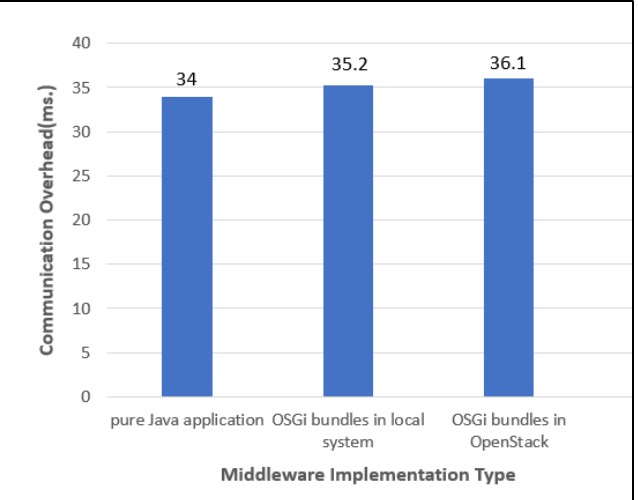
Figure 11. The observed overhead of the middleware according to the implementation types .